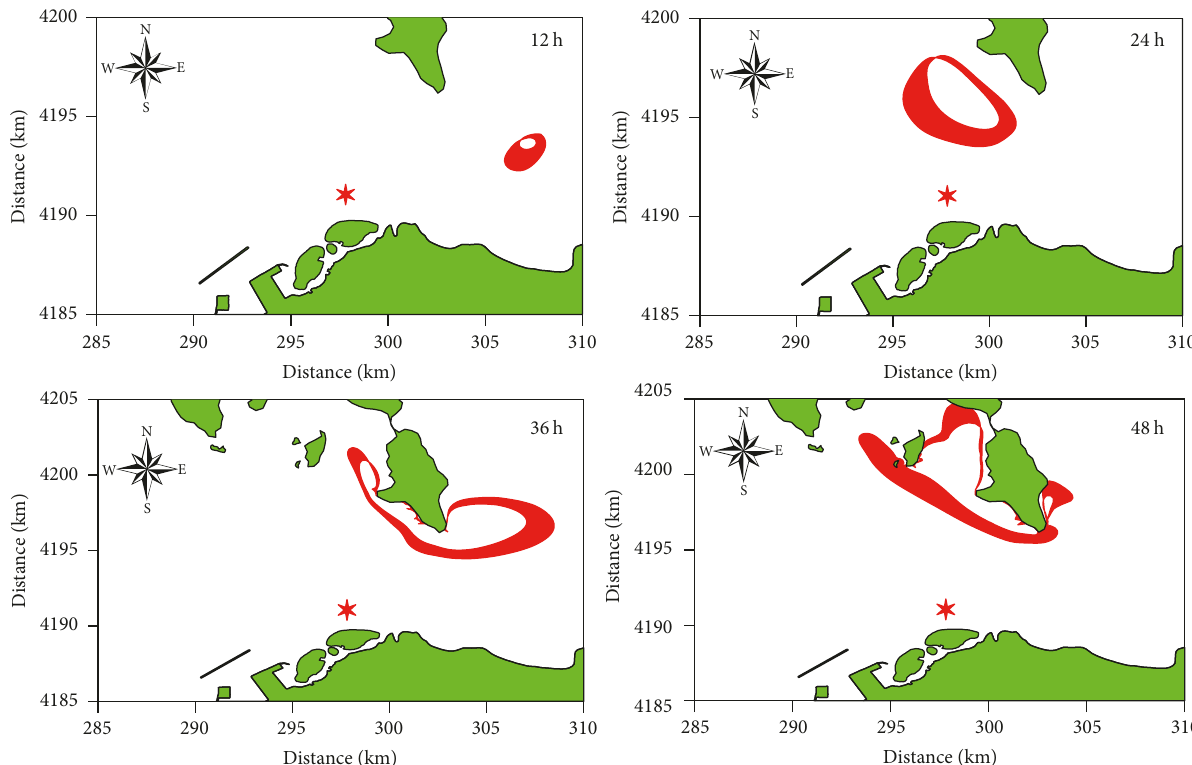
Figure 17: Transport processes of instantaneous oil spills (red area) from the eastern portion of the channel (red star symbol for the eastern spill location) under the influence of south winds.